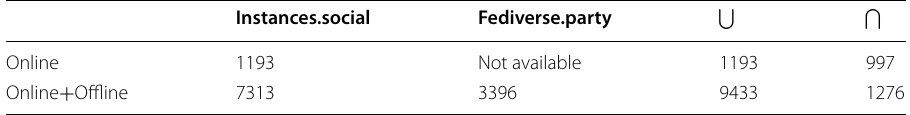
Symbol (cid:31) , resp. (cid:31) , stands for the total of Mastodon instances calculated as the size of the set union, resp. intersection, between the instances set provided by the